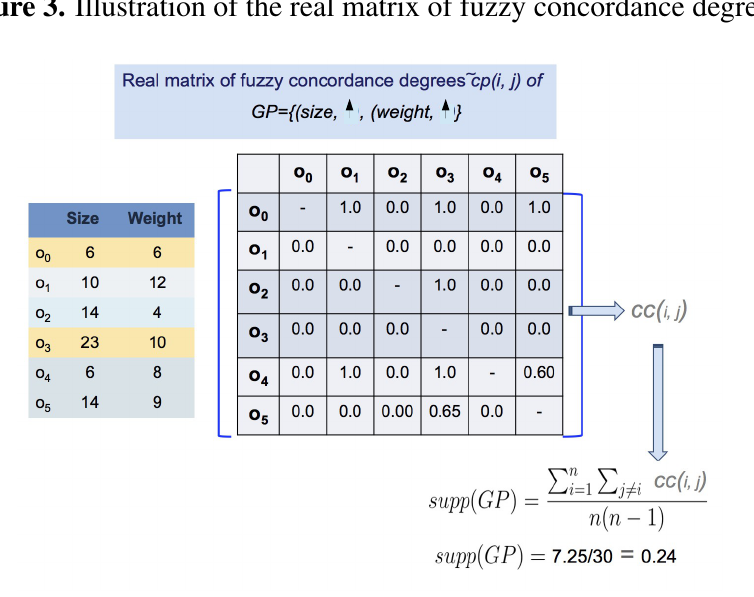
Figure 3. Illustration of the real matrix of fuzzy concordance degrees.